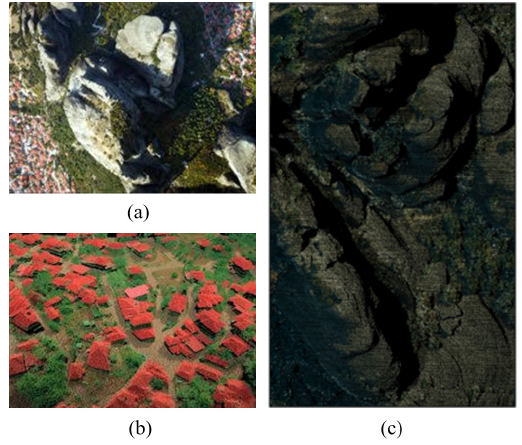
Figure 5. LiDAR data and processing stages: (a) Aerial image captured by the camera of the airborne mapping system; (b) result of the feature detection and extraction process using the point cloud; (c) Final point cloud with color mapping